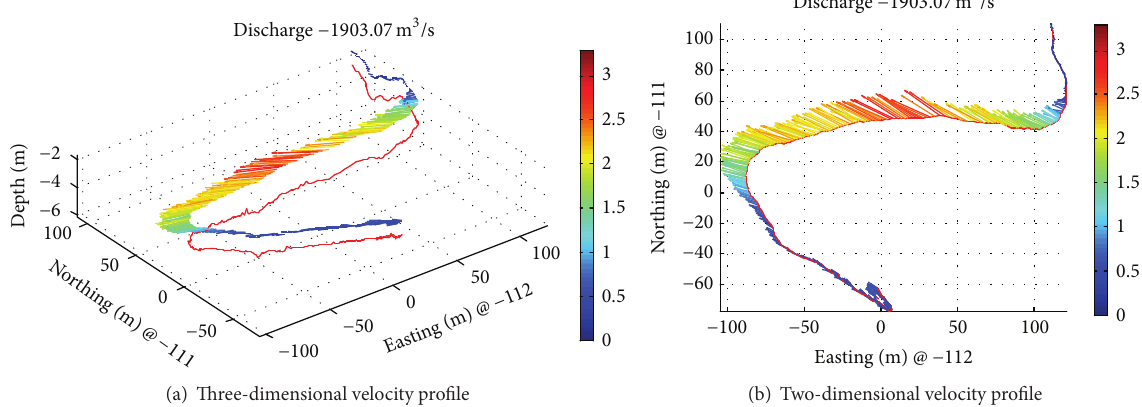
Figure 7: Vertically averaged velocity profile and discharge (Case